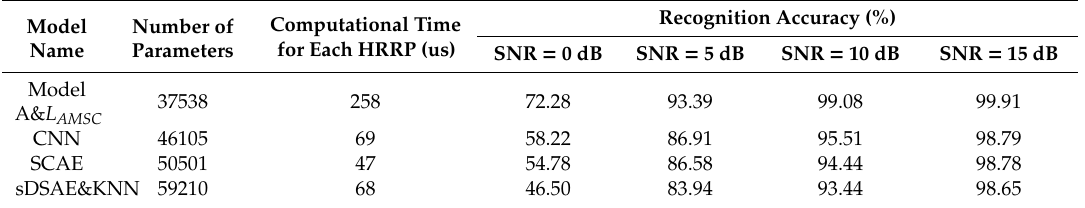
Table 7. Recognition accuracy of model A and the comparison model under di ff erent SNR